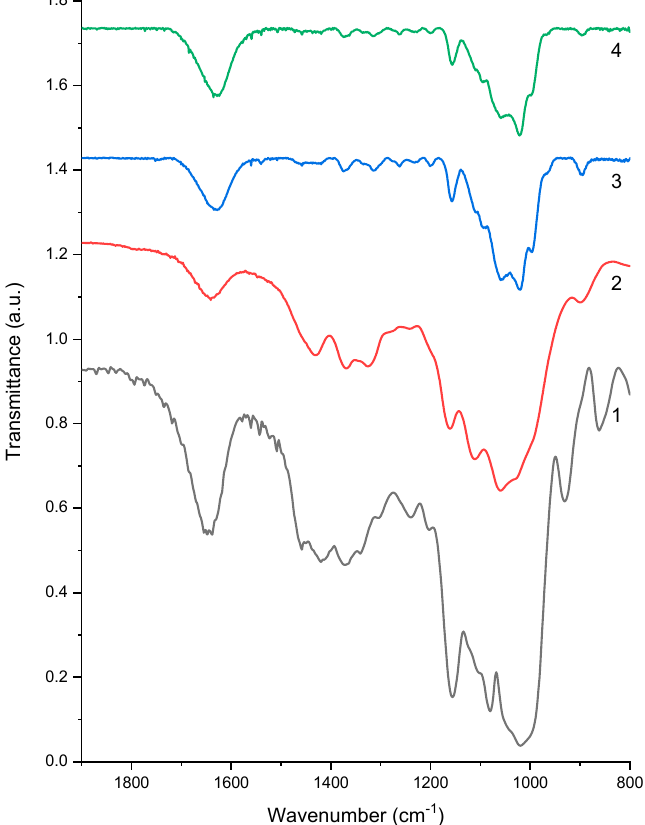
Figure 6. FTIR results of the (1) native Gelose 80 starch, (2) native MCC, (3) pure-cellulose film C100, and (4) cellulose-based blend film C70.